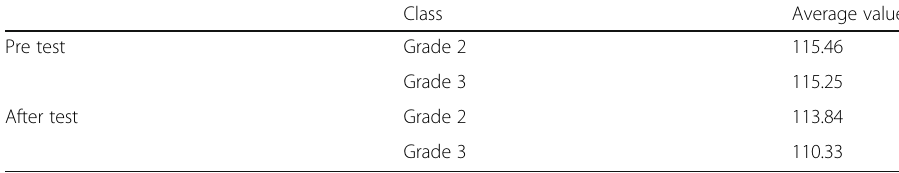
Table 4 Comparison of English comprehensive ability test results before and after the experiment